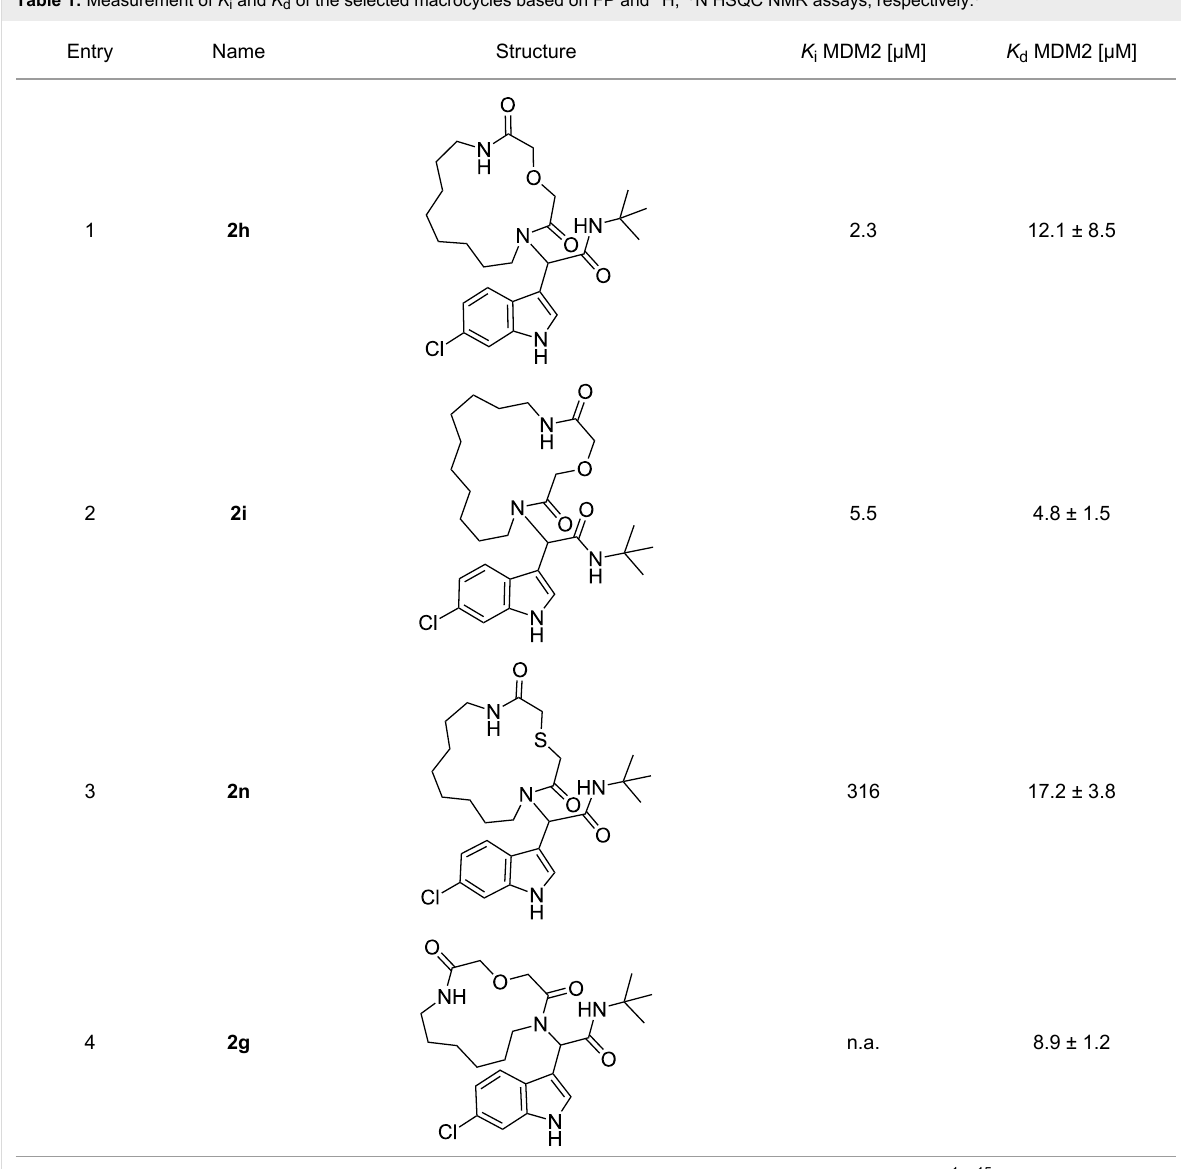
Table 1: Measurement of K i and K d of the selected macrocycles based on FP and 1 H, 15 N HSQC NMR assays, respectively.